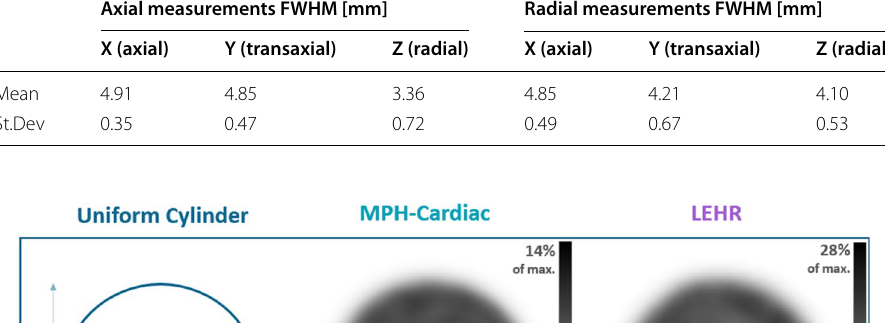
Table 1 Mean and Standard Deviation (St. Dev.) values of FWHM spatial resolution results calculated on the reconstructed images, measured along the central axis and through the centrum of the FOV in the radial directions Axial measurements FWHM [mm]